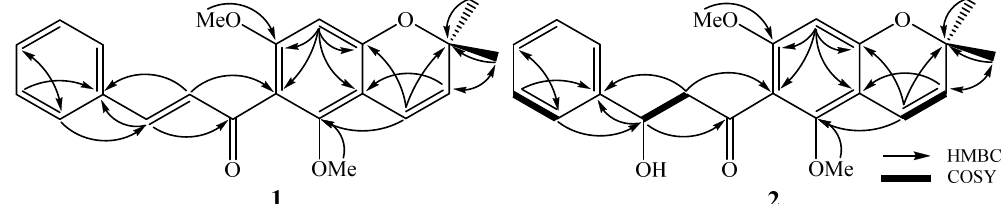
Figure 2. The key HMBC and COSY correlations of compounds 1 and 2.